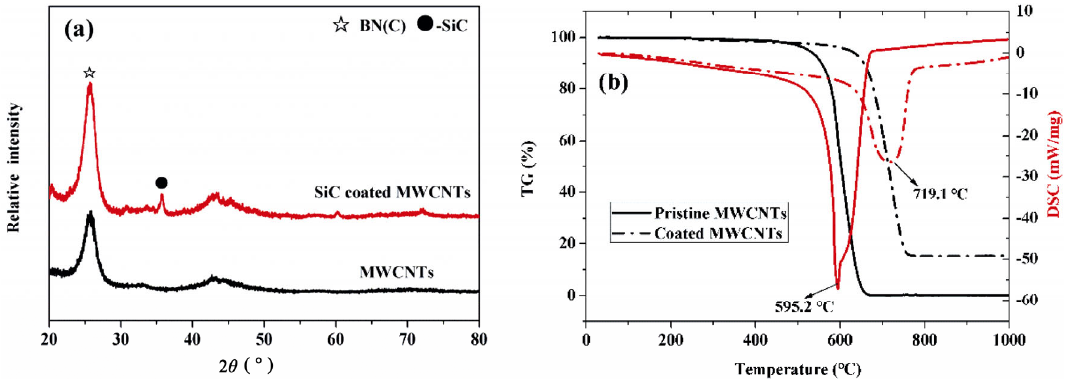
Fig. 3 (a) XRD patterns and (b) TG–DSC curves of MWCNTs with and without SiC